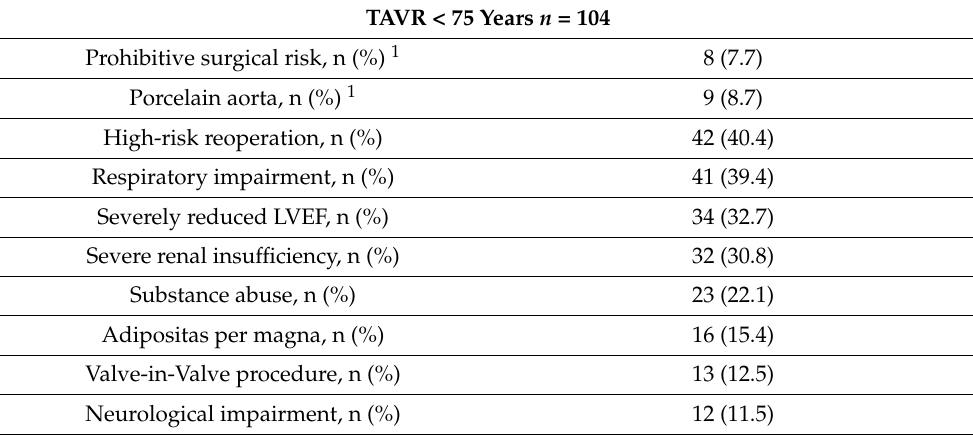
Table 1. Factors impacting the choice of TAVR over